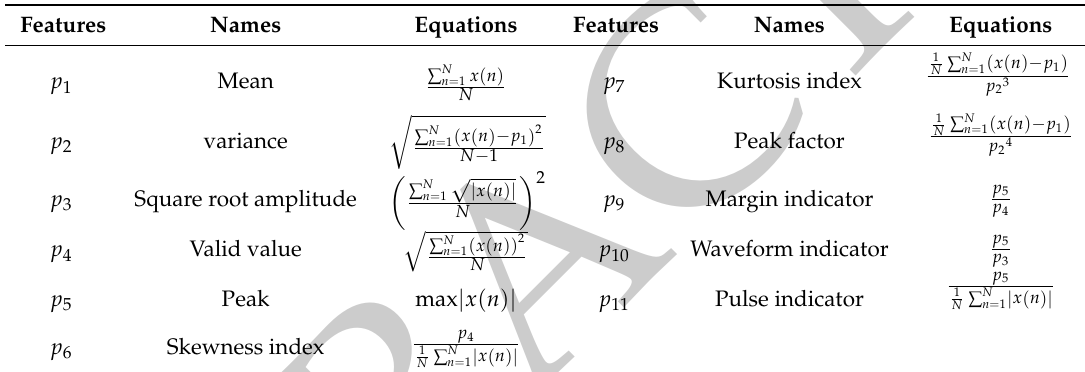
Table 1. Features in Time-domain.